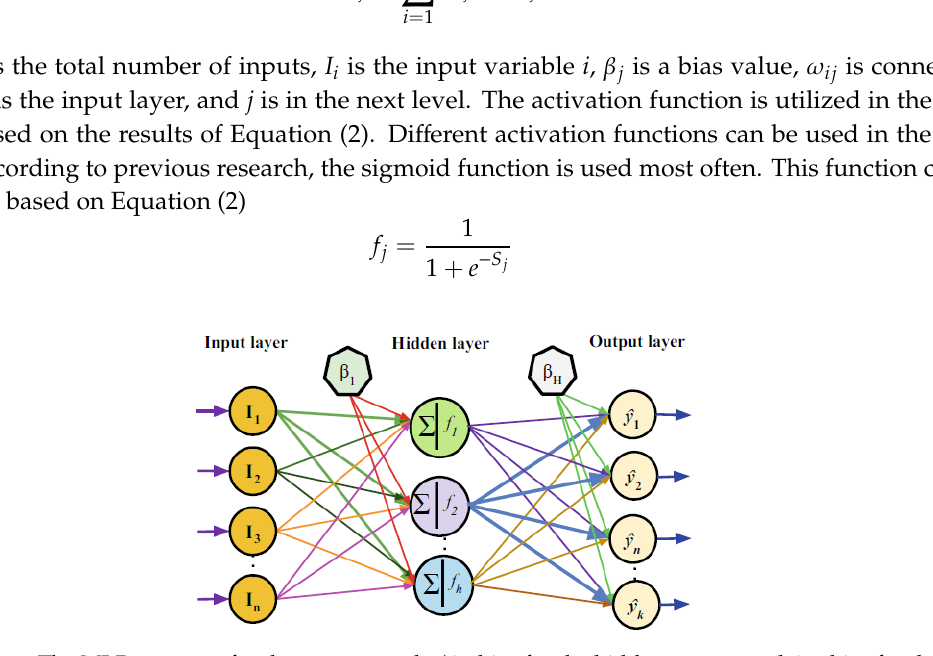
Figure 2. The MLP structure for the current study ( β I : bias for the hidden neuron and β H : bias for the output neuron).